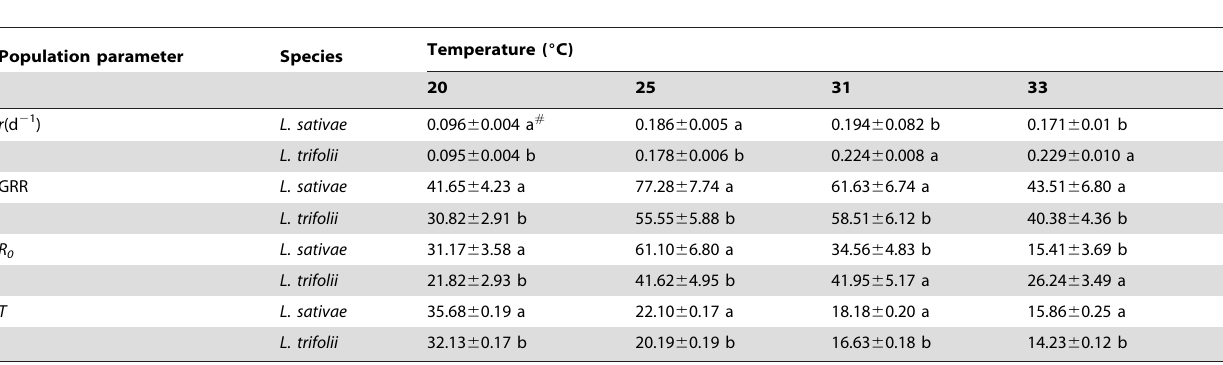
Table 2. Estimates of life table population parameters ( x 6 SE) for Liriomyza sativae and L. trifolii reared under different constant temperatures.